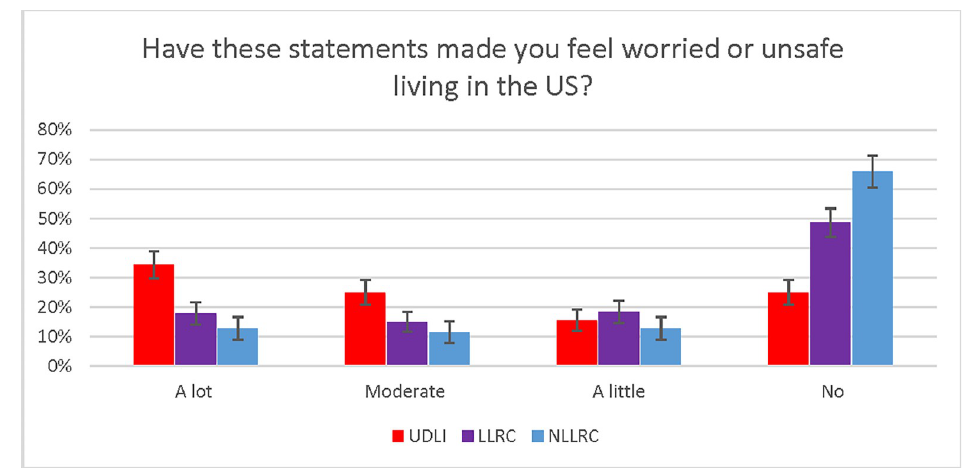
Fig 1. Perceived impact of the president’s statements about immigrants on feelings of safety. UDLI– Undocumented Latino immigrant; LLRC–Latino legal resident/citizen; NLRC–Non-Latino resident/citizen; US– United States. Error bars represent 95% confidence intervals.